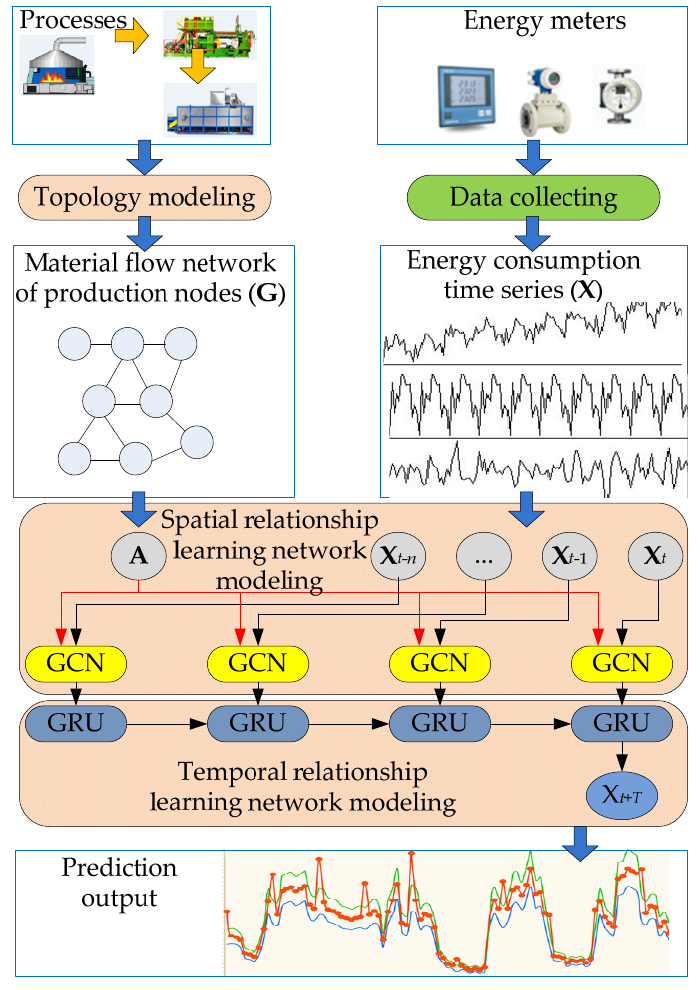
Figure 1. The framework of the STDLN method.